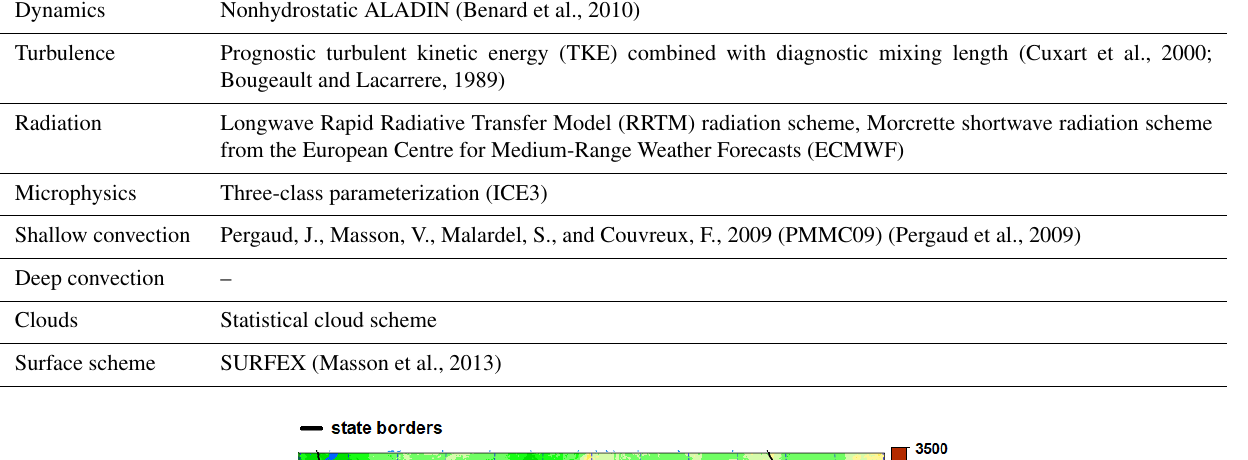
Table A2. Physics schemes used in the AROME CMC 1km model.